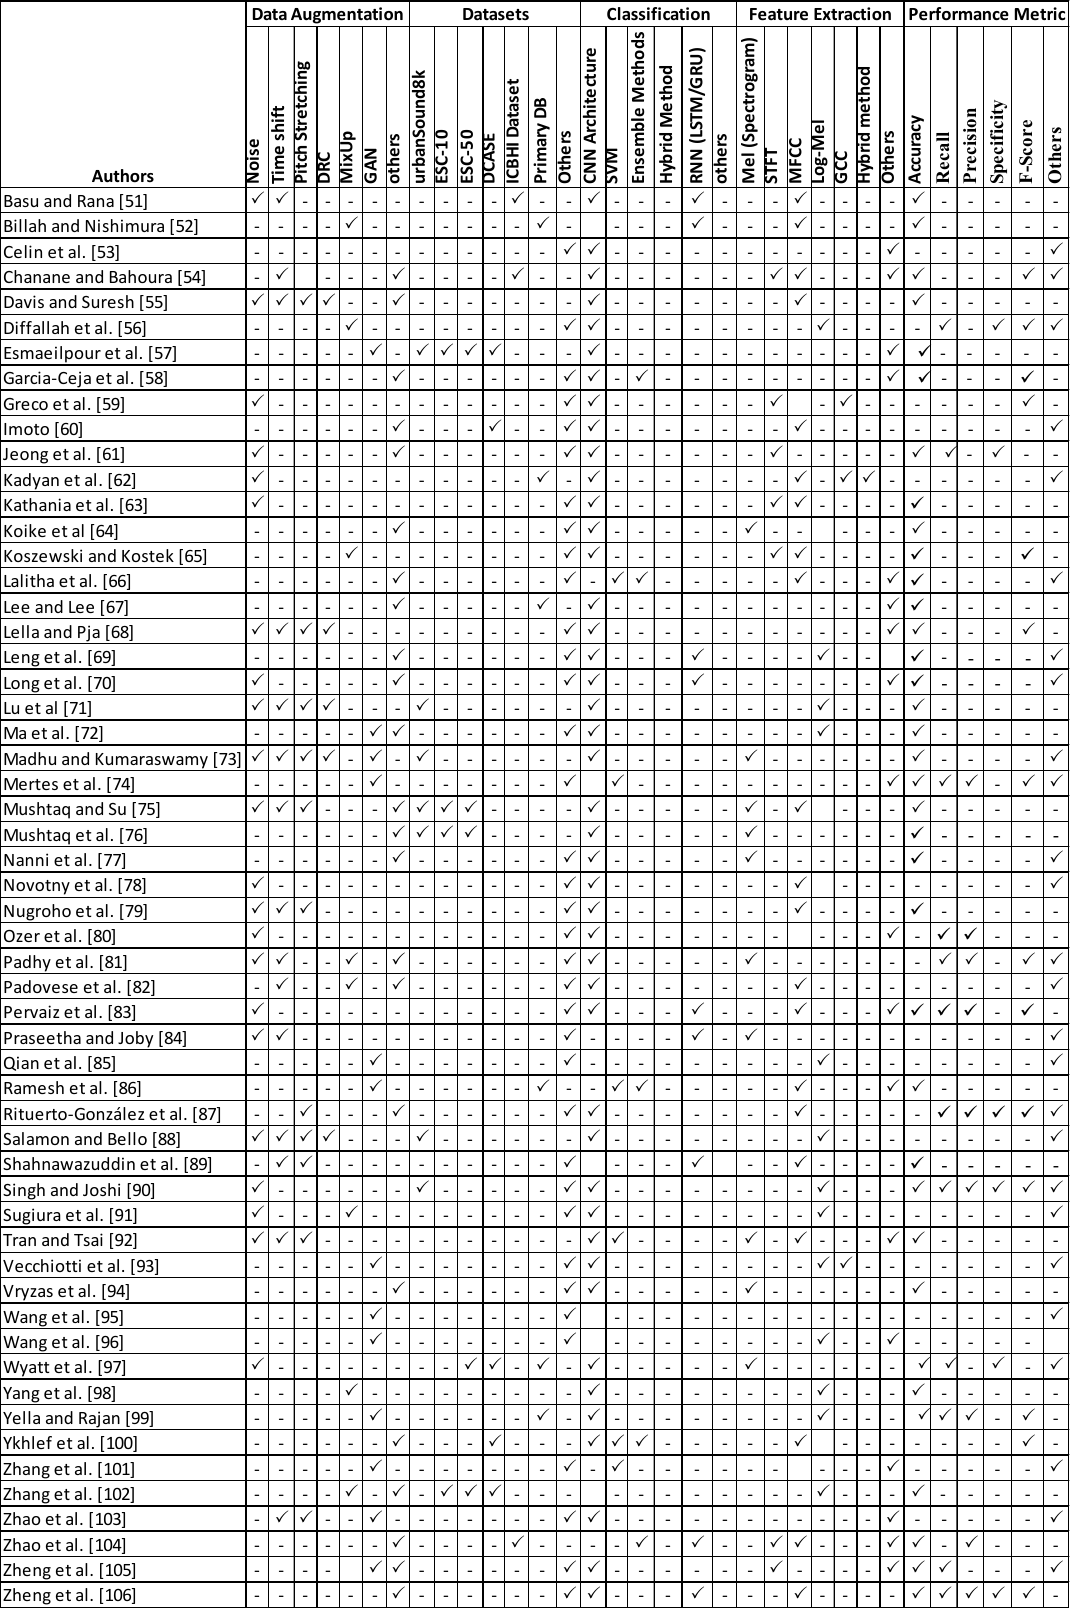
Figure 16. A summary of methods analyzed in this SLR. Symbol ‘ ✓ ’ means that a corresponding method is used in the reference [51–106].